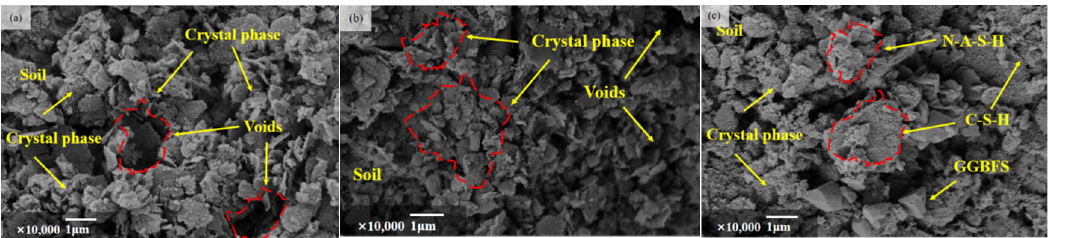
Figure 11. SEM images of the FA, slag (GGBFS), and undisturbed soft soil.